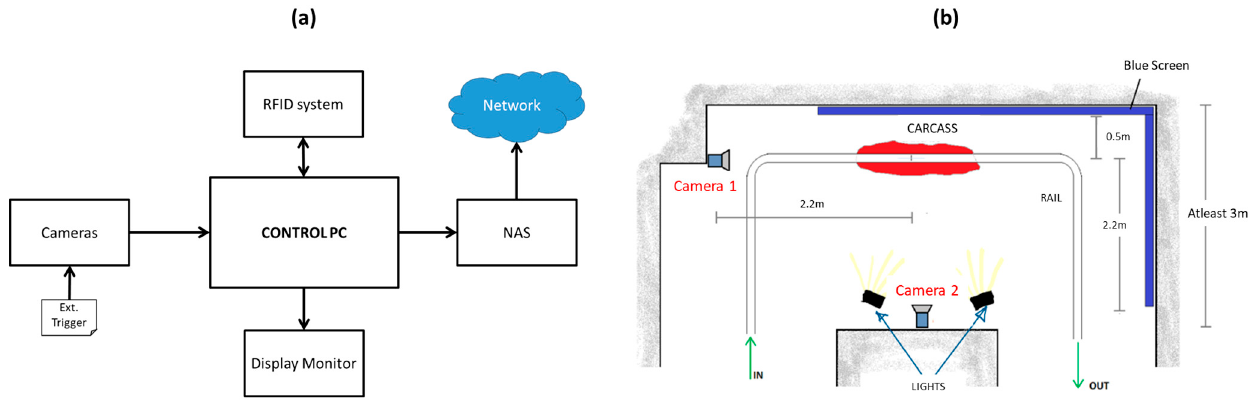
Figure 1. Proposed system: components ( a ) and setup ( b ).